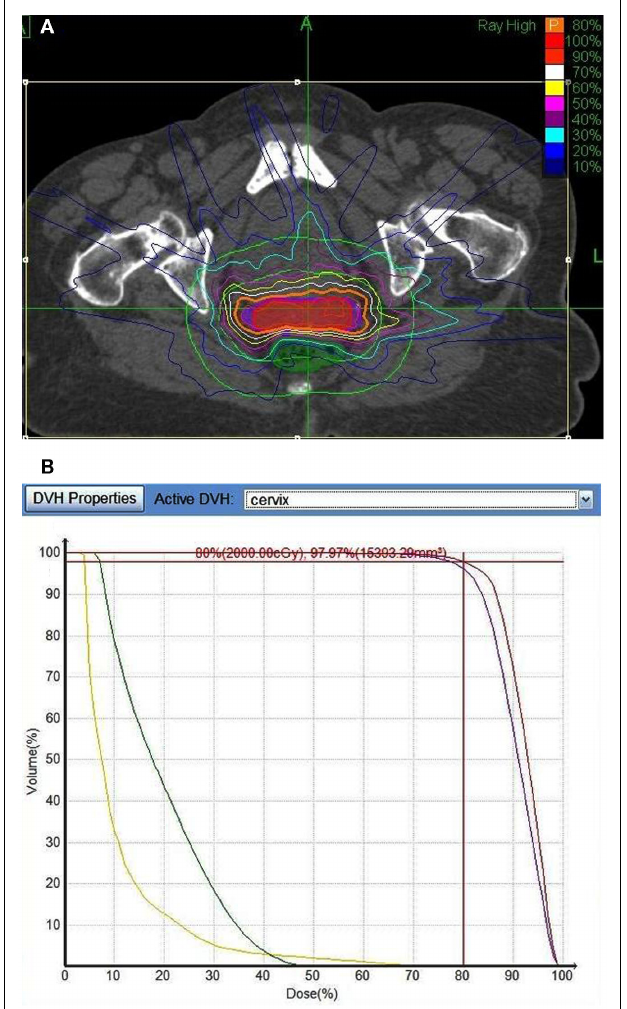
FIGURE 1 | (A) Representative treatment plan for a patient receiving an SBRT boost of 20Gy delivered in four fractions.The orange line denotes the planning target volume (PTV). (B) Dose volume histogram showing the bladder (yellow) rectum (green), cervix (red), and PTV